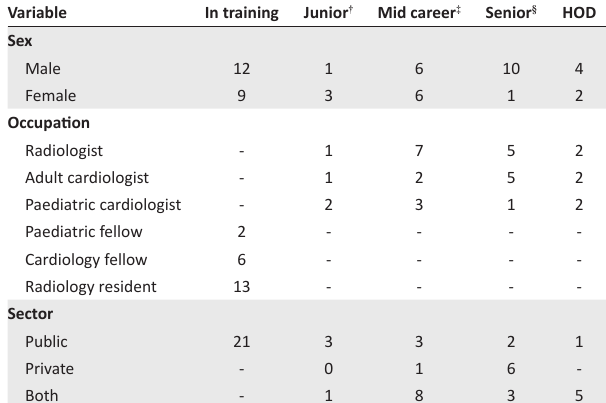
TABLE 1: The characteristics of 54 participants in six group interviews and 30 in-depth